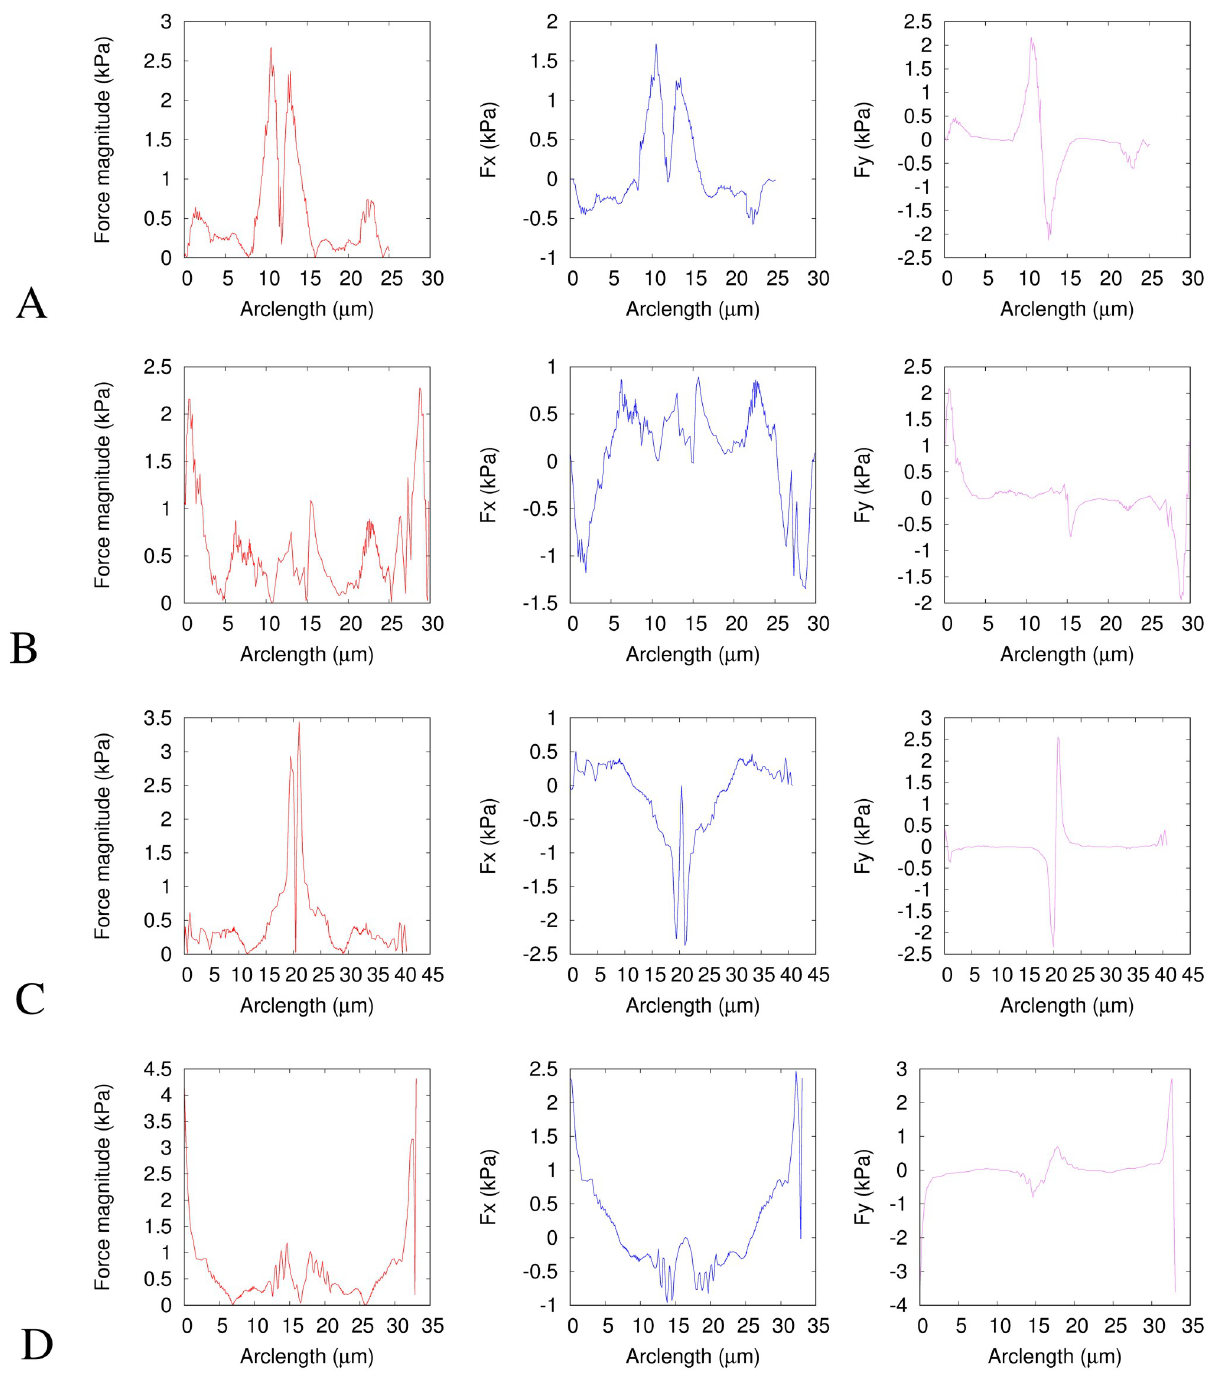
Fig 7. Traction force fields for the shell model. The first column (red curves) shows the traction force magnitudes (the same data as the red arrows in Fig 6). The second column (blue curves) shows the x component of the traction forces (along the channel). The third column (magenta curves) shows the y component of the traction forces (perpendicular to the channel). These are all plotted against the arclength in micrometers. The direction of the arclength coordinate s 1 is anticlockwise as shown in Fig 3. s 1 = 0 corresponds to θ = − π and y = 0 at the rear of the nucleus ( x most negative) in Fig 6. s 1 then increases anticlockwise around the negative y region to the front ( x most positive) then around the positive y region to rear again. The traction force is calculated using a Young’s modulus of E = 5 kPa and assuming that the nucleus behaves as an incompressible elastic solid with a Poisson ratio ν = 0.5. The subfigure rows correspond to the same times as in Fig 6, i.e. A. before to entering constriction, B. entering to within constriction, C. within to exiting constriction and D. exiting to after constriction. A discussion is provided in the main text of the differences between the traction forces between the shell model (shown in this figure) and the solid model (shown in Fig 5).